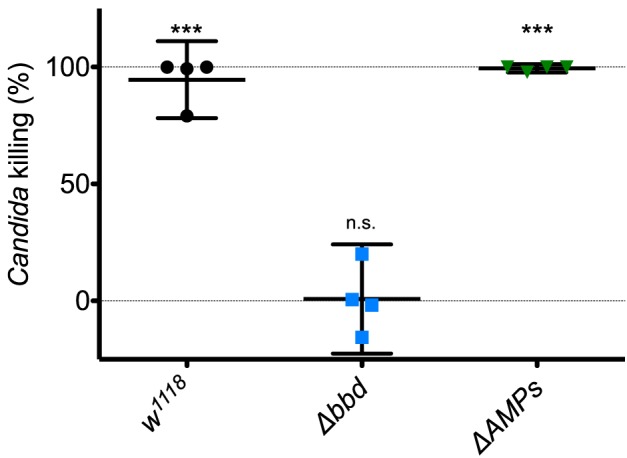
The Toll-induced candidacidal activity of hemolymph requires Bombardier, but neither Drosomycin nor Metchnikowin. Heat-killed M. luteus was used to activate the Toll pathway in flies. Hemolymph was extracted from flies 24 h after Toll induction, mixed with C. glabrata and incubated for 1 h to allow for killing. The surviving yeast cells were plated, and colonies were counted to determine the level of candidacidal activity in the extracted hemolymph. Colony counts from uninduced w1118 hemolymph were used as the control for no (0%) killing. Experiments were completed four times, with each point representing one replicate. One-way ANOVA was calculated followed by Tukey's test. Significance is shown relative to the null hypothesis of 0% killing (***p < 0.0001; n.s., not significant, p > 0.05). Error bars represent the 95% confidence interval.